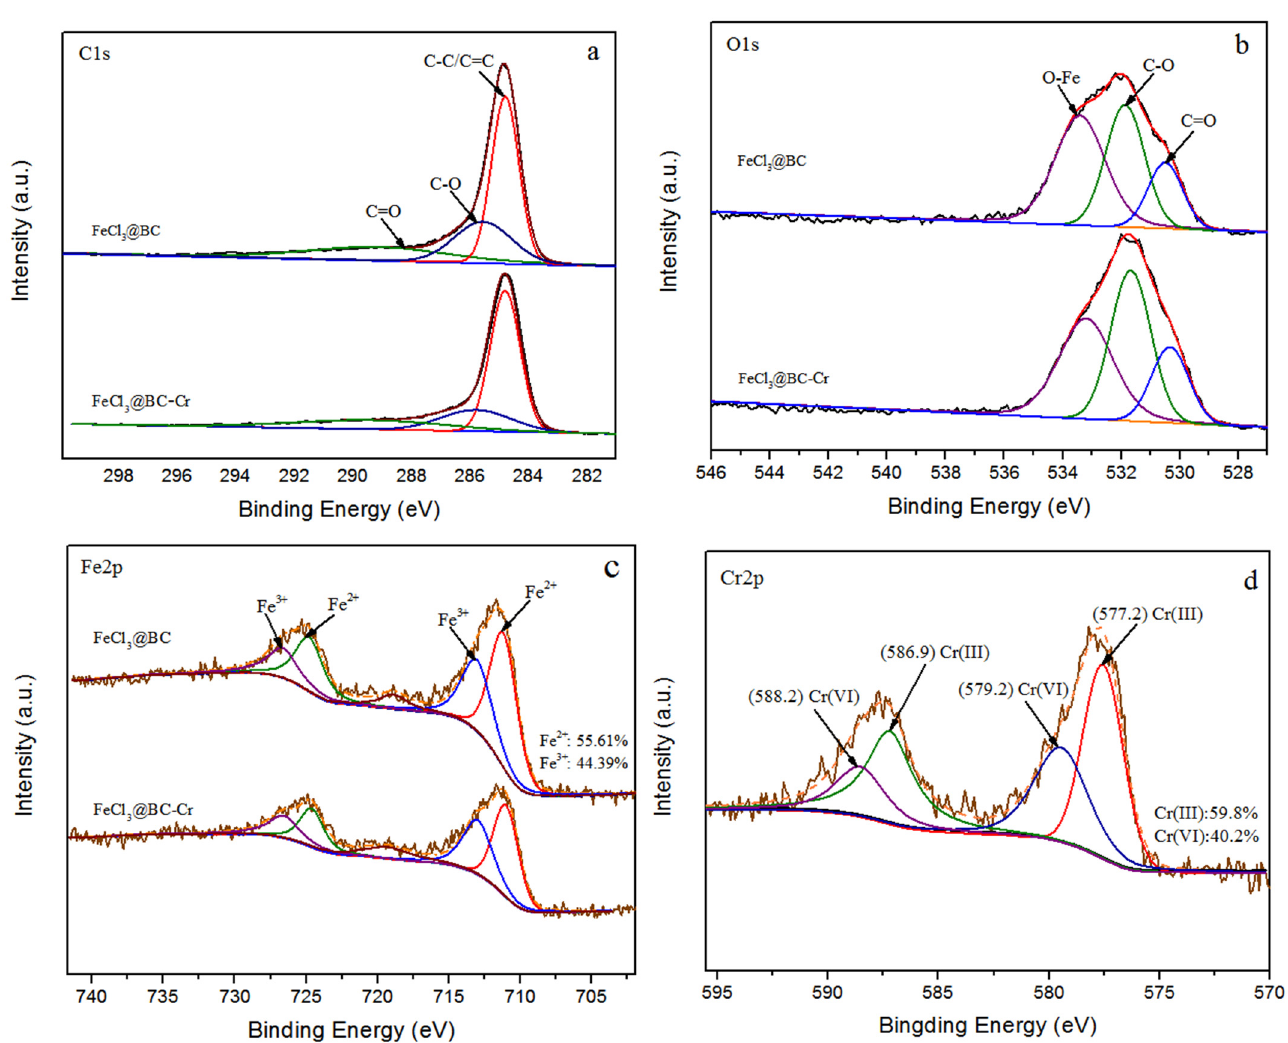
Figure 6. C1s spectra ( a ), O1s spectra ( b ), Fe2p spectra of FeCl 3 @BC before and after the reaction ( c ), and Cr2p spectra of FeCl 3 @BC after reaction ( d ).